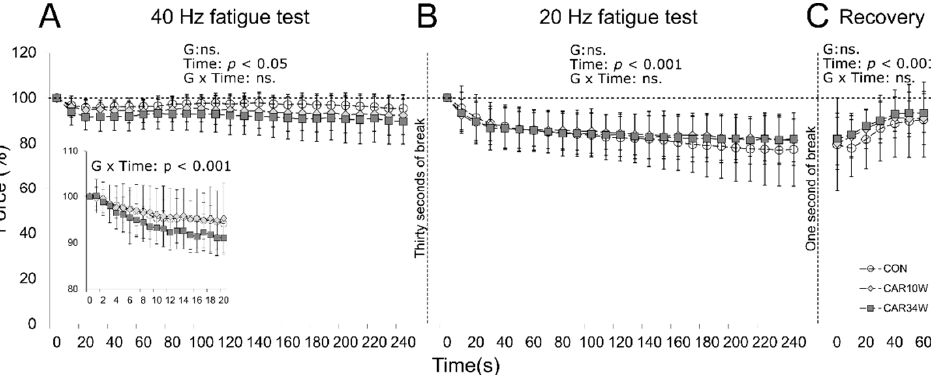
Figure 3. Effects of carnosine supplementation in the course of the first ( A ) and second ( B ) fatigue tests, as well as the recovery period ( C ), in slow MUs. Peak forces were presented every 10 s and expressed as percentages of the peak force of the first tetanus (100%) generated at the beginning of each fatigue test. The inset panel in A presents forces generated every second during the first 20 s of stimulation. The forces generated during the recovery phase were expressed as percentages of the peak force of the first tetanus recorded in the second test. CON refers to the non ‐ supplemented group, CAR10W to the 10 weeks ‐ supplemented group, and CAR34W to the 34 weeks ‐ supplemented group.